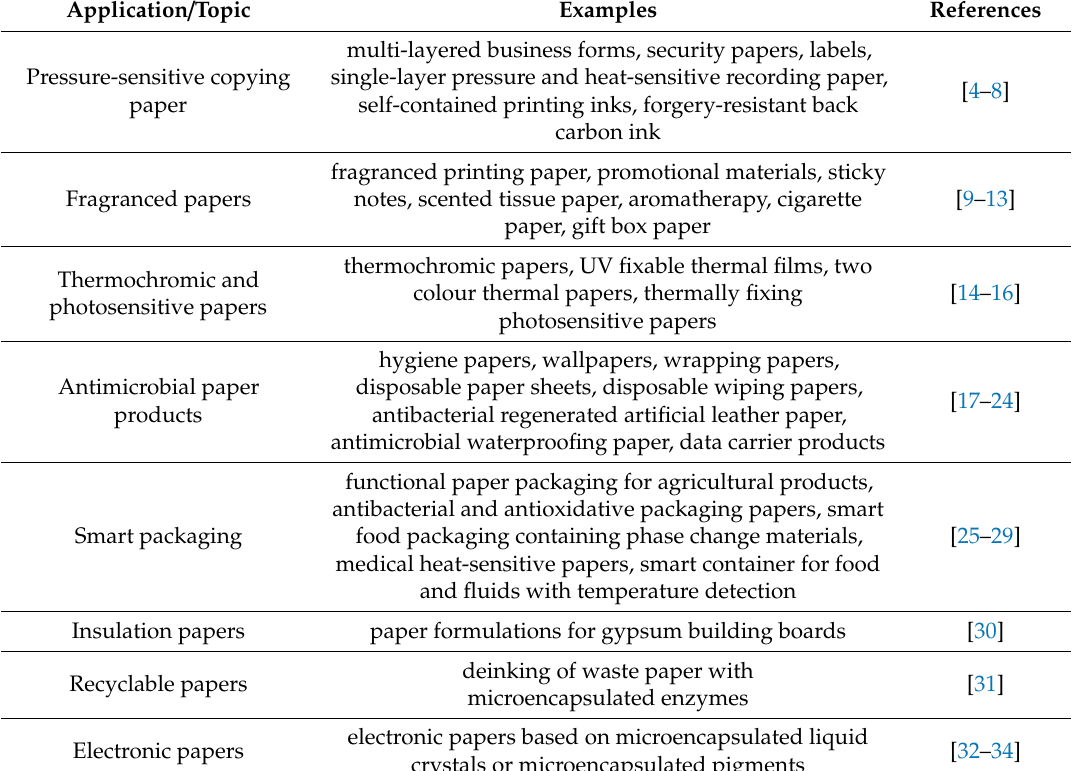
Table 1. Identified topics of microencapsulation in paper industries for functional papers. Application/Topic